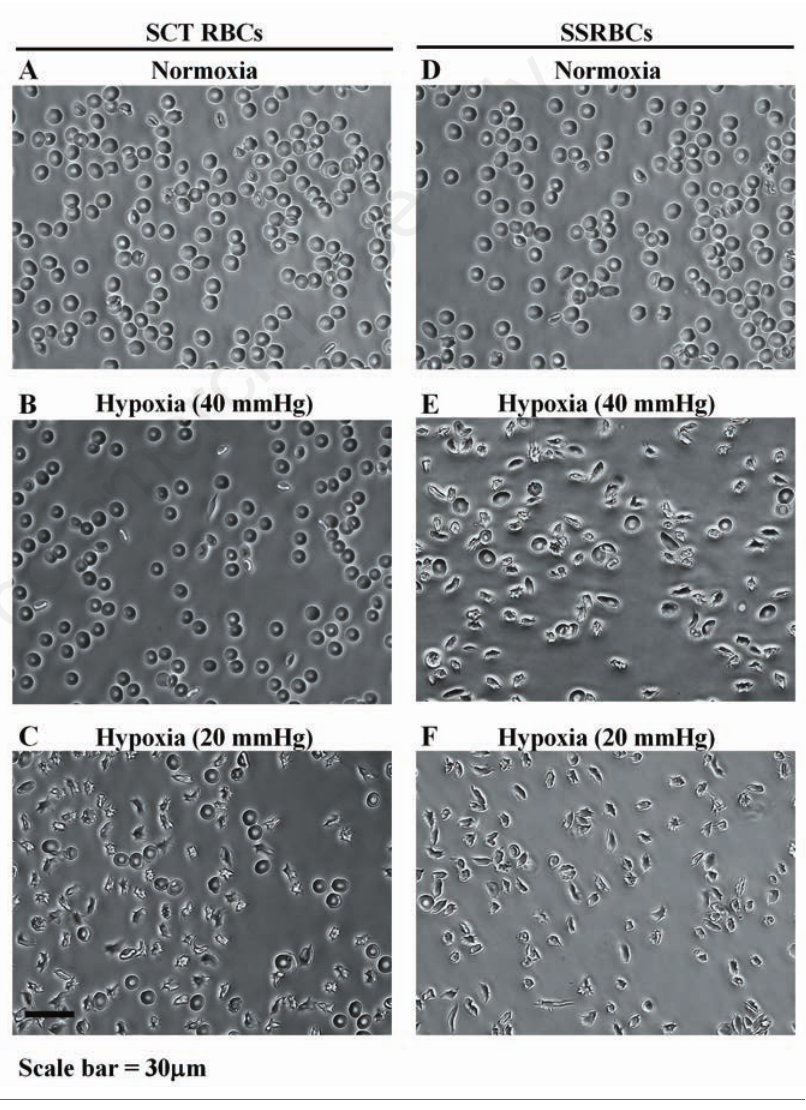
Figure 1. Isolated sickle cell trait (SCT) red blood cells (RBCs) sickle under severe hypoxic conditions. A) and D) Representative images of SCT RBCs and sickling of sickle RBCs (SSRBCs) incubated under normoxia, respectively. B) and C) Representative images of SCT RBCs incubated under 40 mm Hg (resting hypoxia) and 20 mm Hg (severe hypoxia), respectively. E) and F) Similar to B and C except images represent